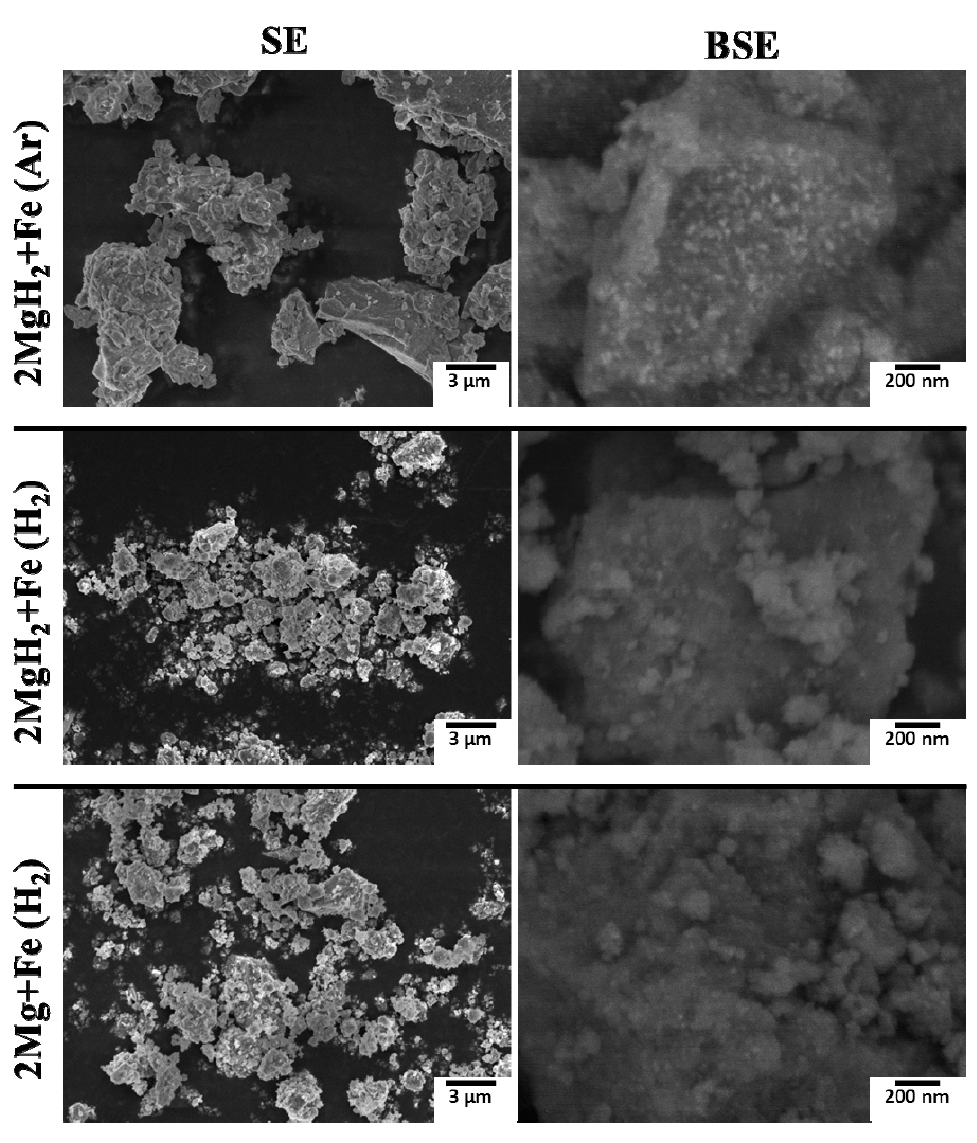
Figure 2. SEM micrographs of ball milled samples. The left and right columns show respectively the secondary (SE) and back-scattered electron (BSE)